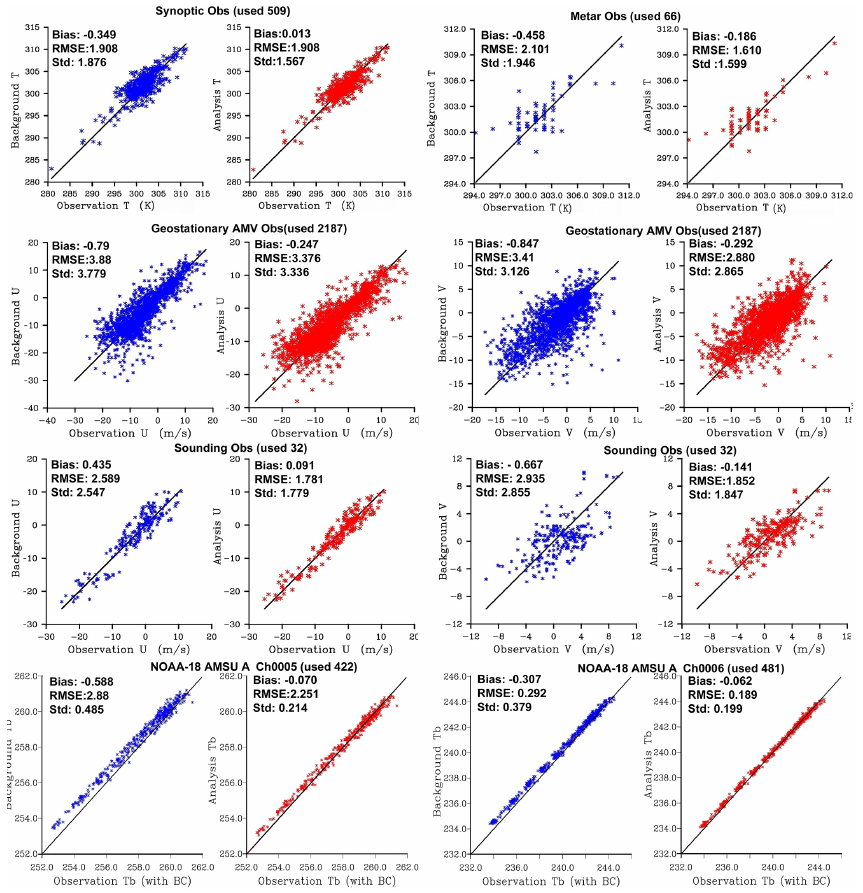
Figure 3. Scatter plot of observations versus first guess (in blue) and 3D-Var analysis (in red) for temperature and wind for VARPREP + RAD corresponding to the analysis time 12:00UTC 9 October